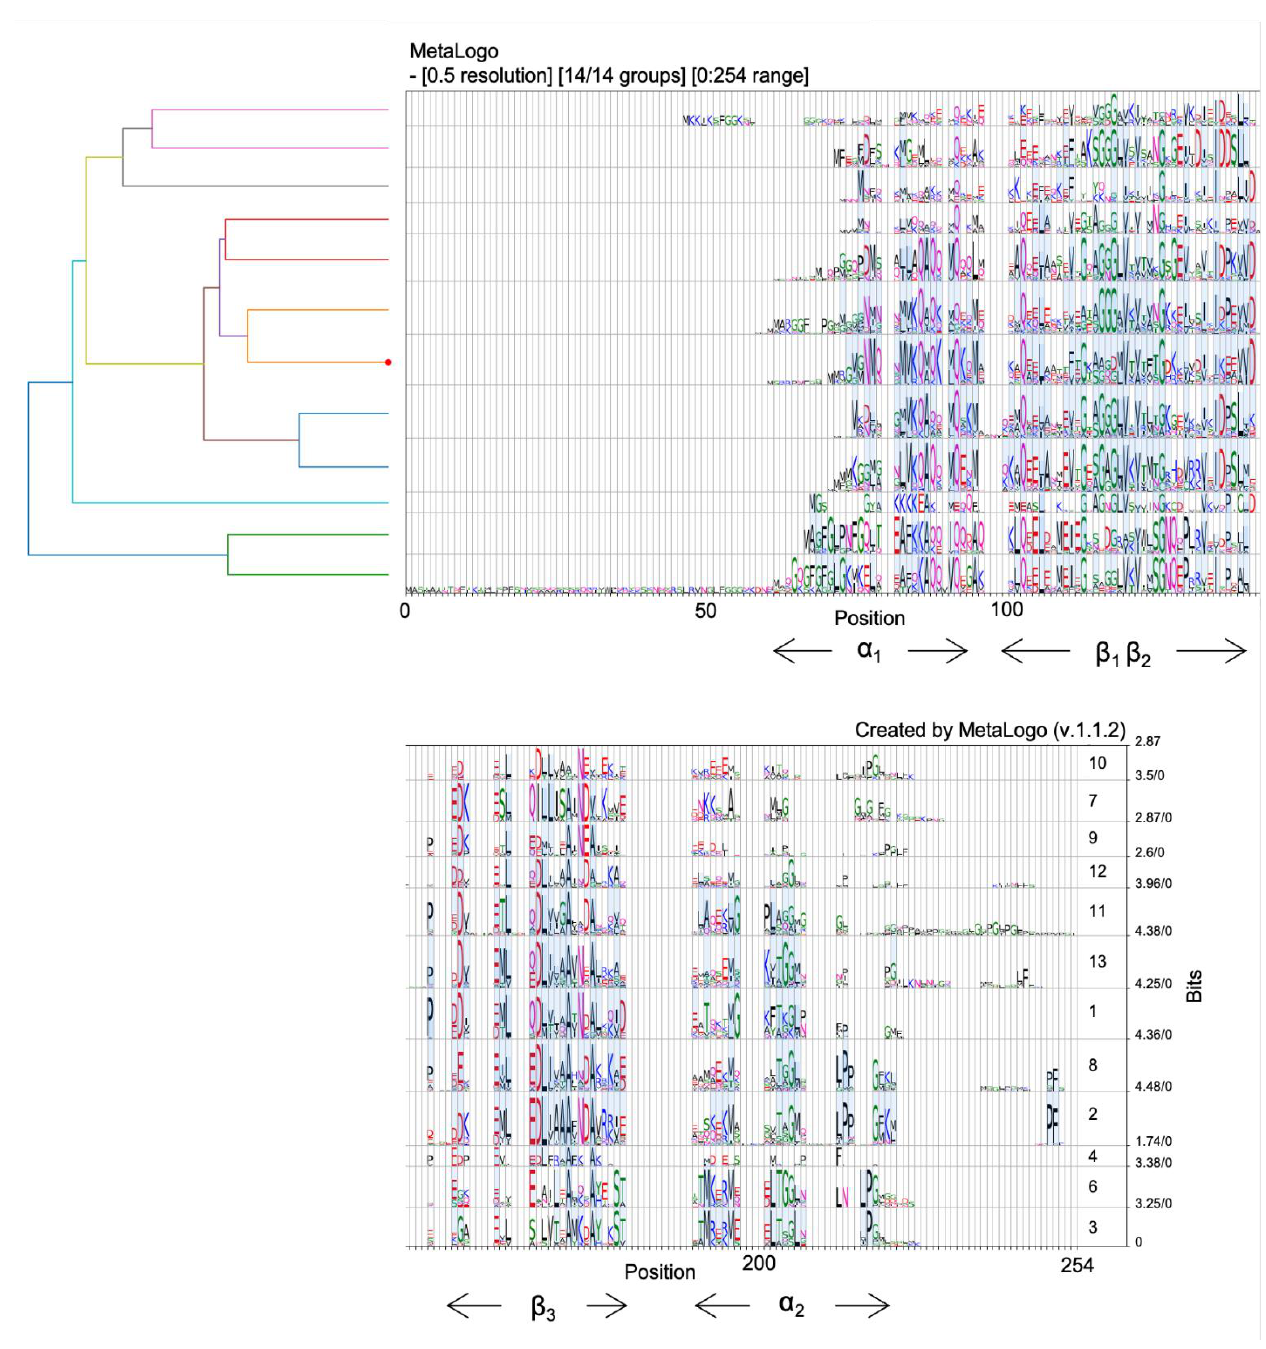
Figure 3. Sequence logos for all the reviewed putative proteins belonging to the YbaB/EbfC family (IPR004401). The putative sequences are deposited in the InterPro protein families and domains database [44]. The database contains 585 reviewed sequences. Sequence logos were constructed using MetaLogo [45]. The tree on the left indicates the relationships among the groups. The red dot on the tree shows the group containing the target sequence. Light blue coloured strips connect conserved positions among groups. Check Supplementary Figure S1 for a complete view of Figure 3.